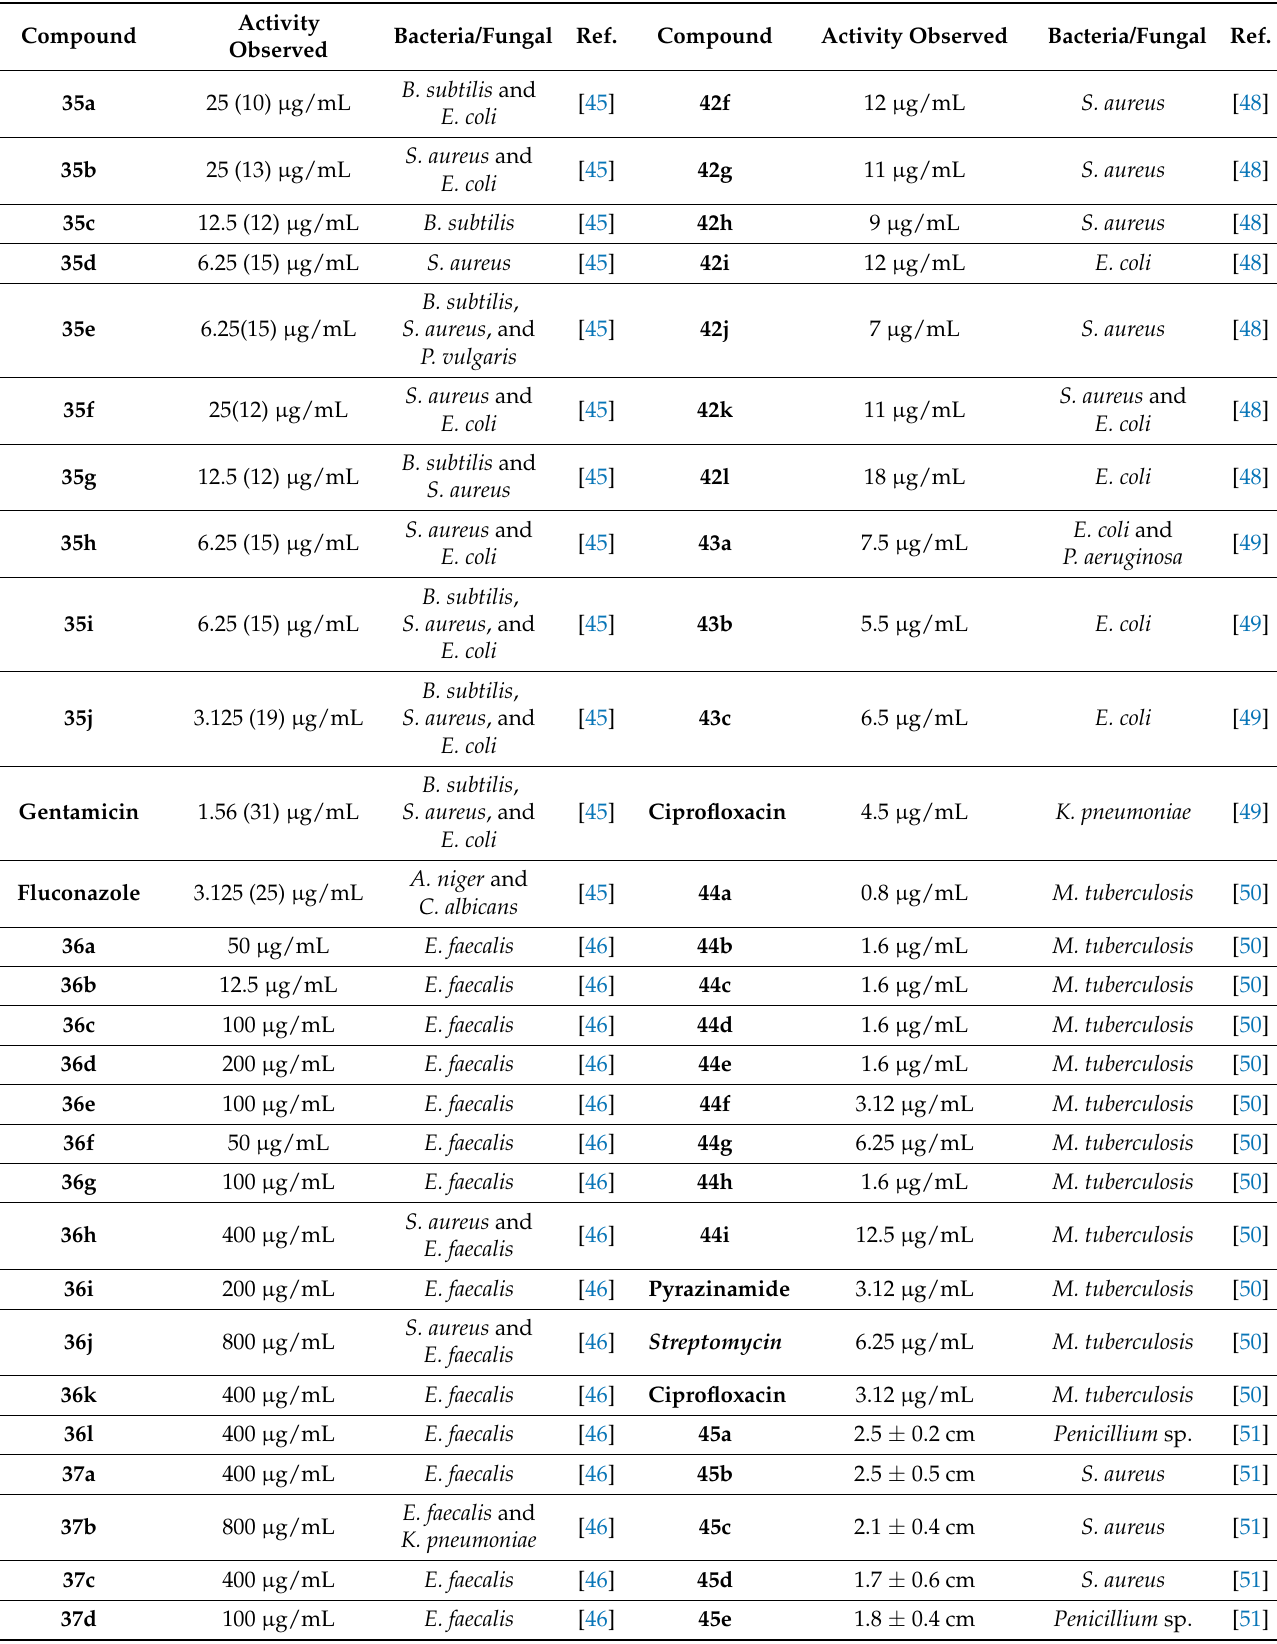
Table 4. Antimicrobial activity data of reported coumarin triazole